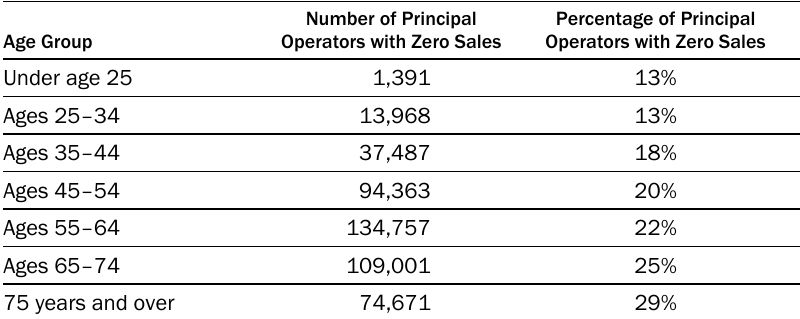
Table 2. Principal Operators with Zero Sales by Age, 2012